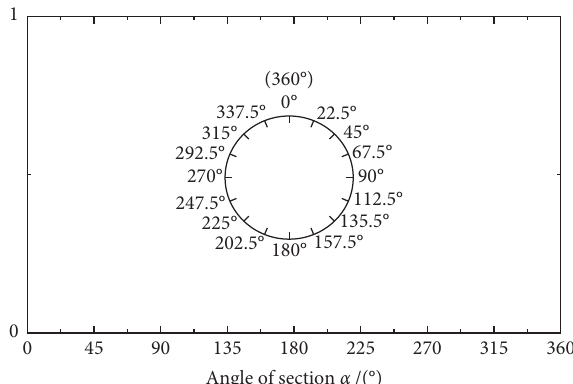
Figure 8: Horizontal coordinates corresponding to the location of the tunnel segment.